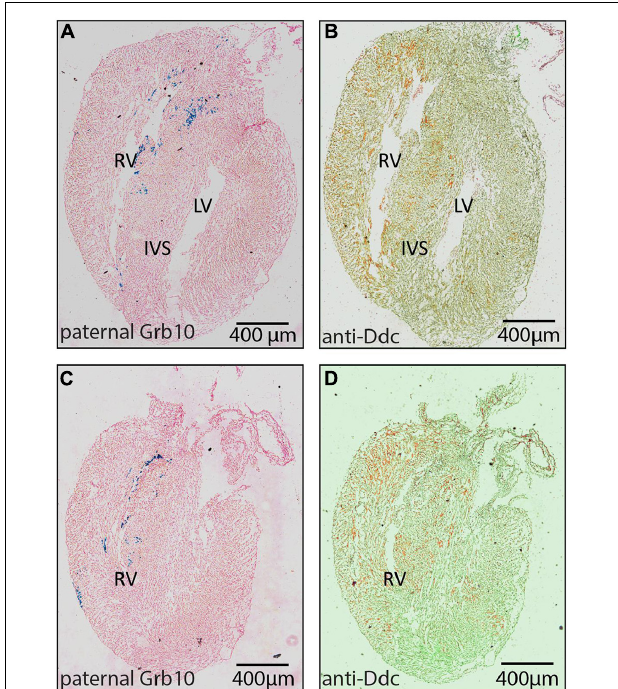
FIGURE 2 | Analysis of paternal Grb10 expression and DDC protein staining in E18.5 heart serial sections. (A,B) are serial sections in the sagittal plane showing the right ventricle (RV) and the left ventricle (LV). (C,D) are serial sections showing only the RV where DDC staining is most abundant. (A,C) are stained with X-gal to reveal paternal Grb10 expression in blue from the lacZ reporter construct and the counterstaining is pink. (B,D) are stained for DDC protein using DAB (brown) via immunohistochemistry, counterstaining is pale green. DDC protein distribution is extensive compared to Grb10 which is restricted to the inter ventricular septum (IVS). Minimum number of hearts examined = 3, maximum number =